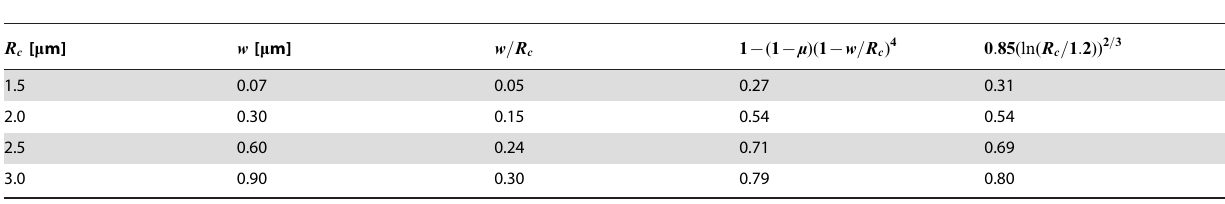
Table 1. Parameters affecting the effective blood